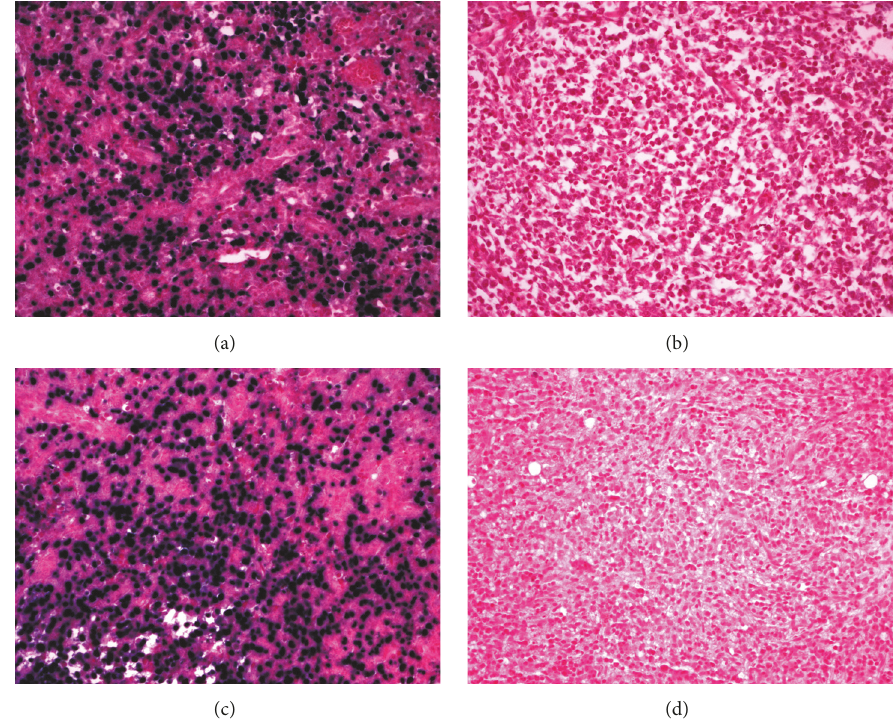
Figure 2: EBER-ISH of lymph node and bone marrow. (a) and (c) Positive controls of lymph node and in bone marrow, respectively. (b) and (d) Negative EBER-ISH in the lymph node and bone marrow of the current patient,